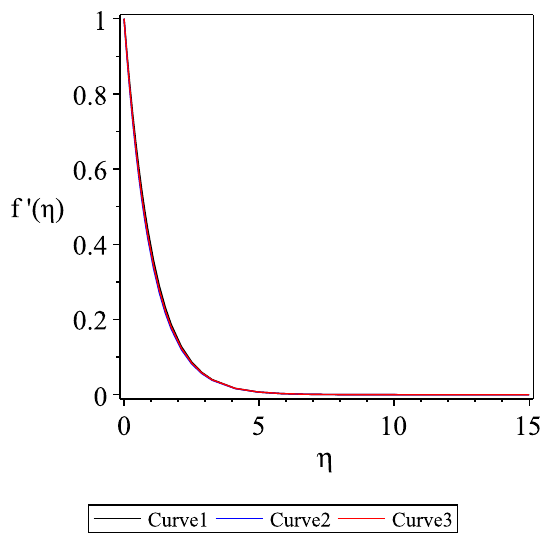
Fig. 6 Plot of (cid:98) f (cid:48) ( η ) , where Curve 1 has Le = 2, Nb = 2, Pr = 1, Nt = 1, n = 0 . 5, Curve 2 has Le = 3, Nb = 1, Pr = 5, Nt = 0, n = 1, and Curve 3 has Le = 2, Nb = 2, Pr = 7, Nt = 0 . 5, n = 0 . 8 using their respective error-minimizing convergence control